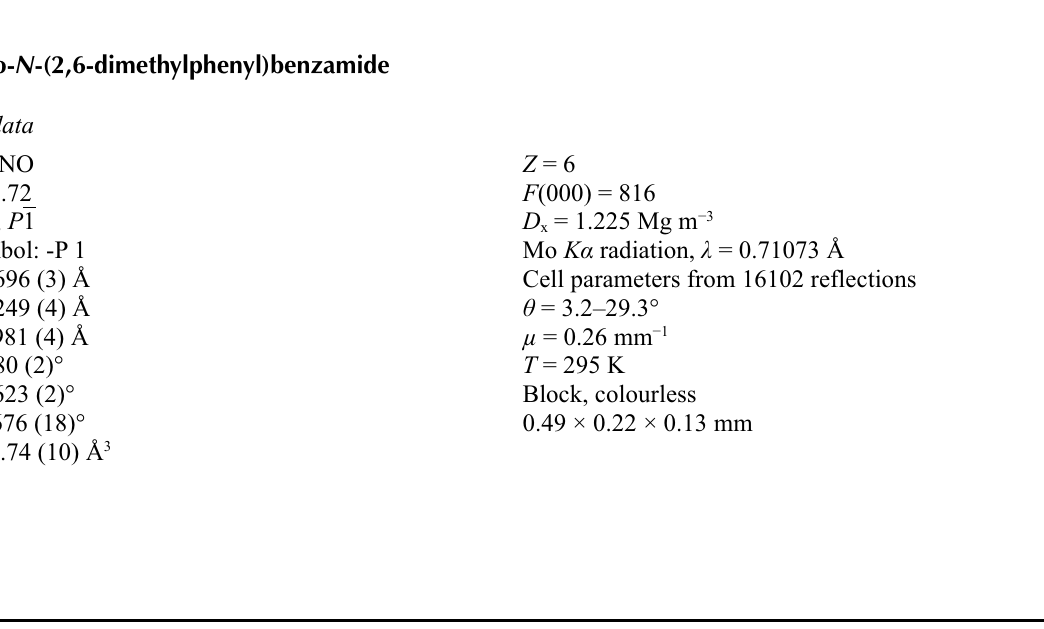
Molecular structure of the title compound showing the atom labelling scheme. Displacement ellipsoids are drawn at the 30% probability level. In molecule 3 only the A-component of the disordered xylyl ring is shown (atoms C48A to C55A). Hydrogen bonds are represented as dashed lines. H atoms not involved in hydrogen bondings have been omitted for